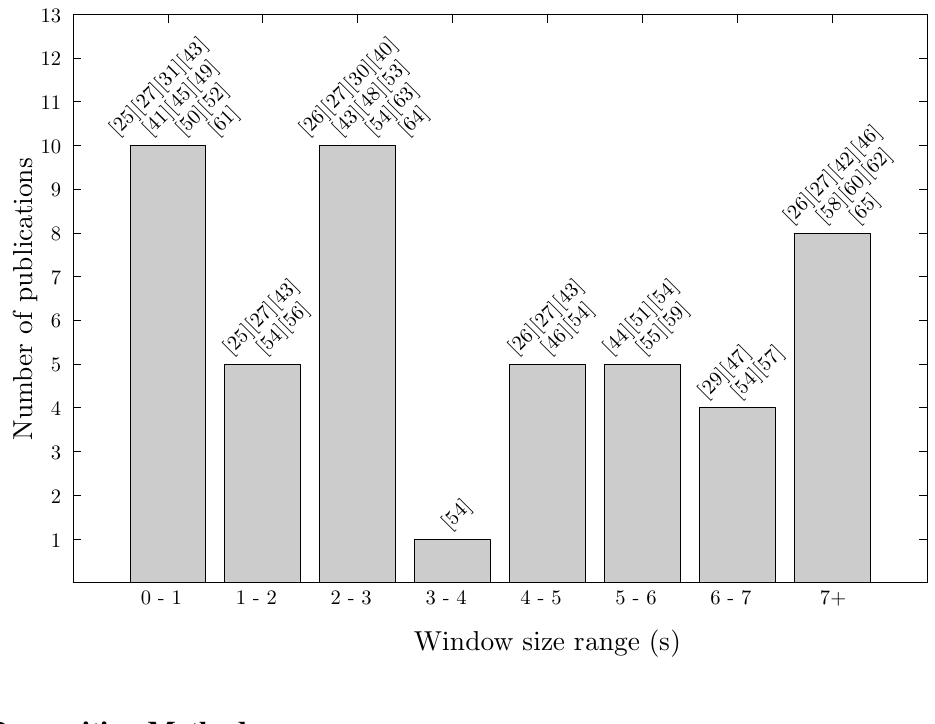
Figure 1. Distribution of the activity recognition research studies presented in Tables 2 and 3 based on the window